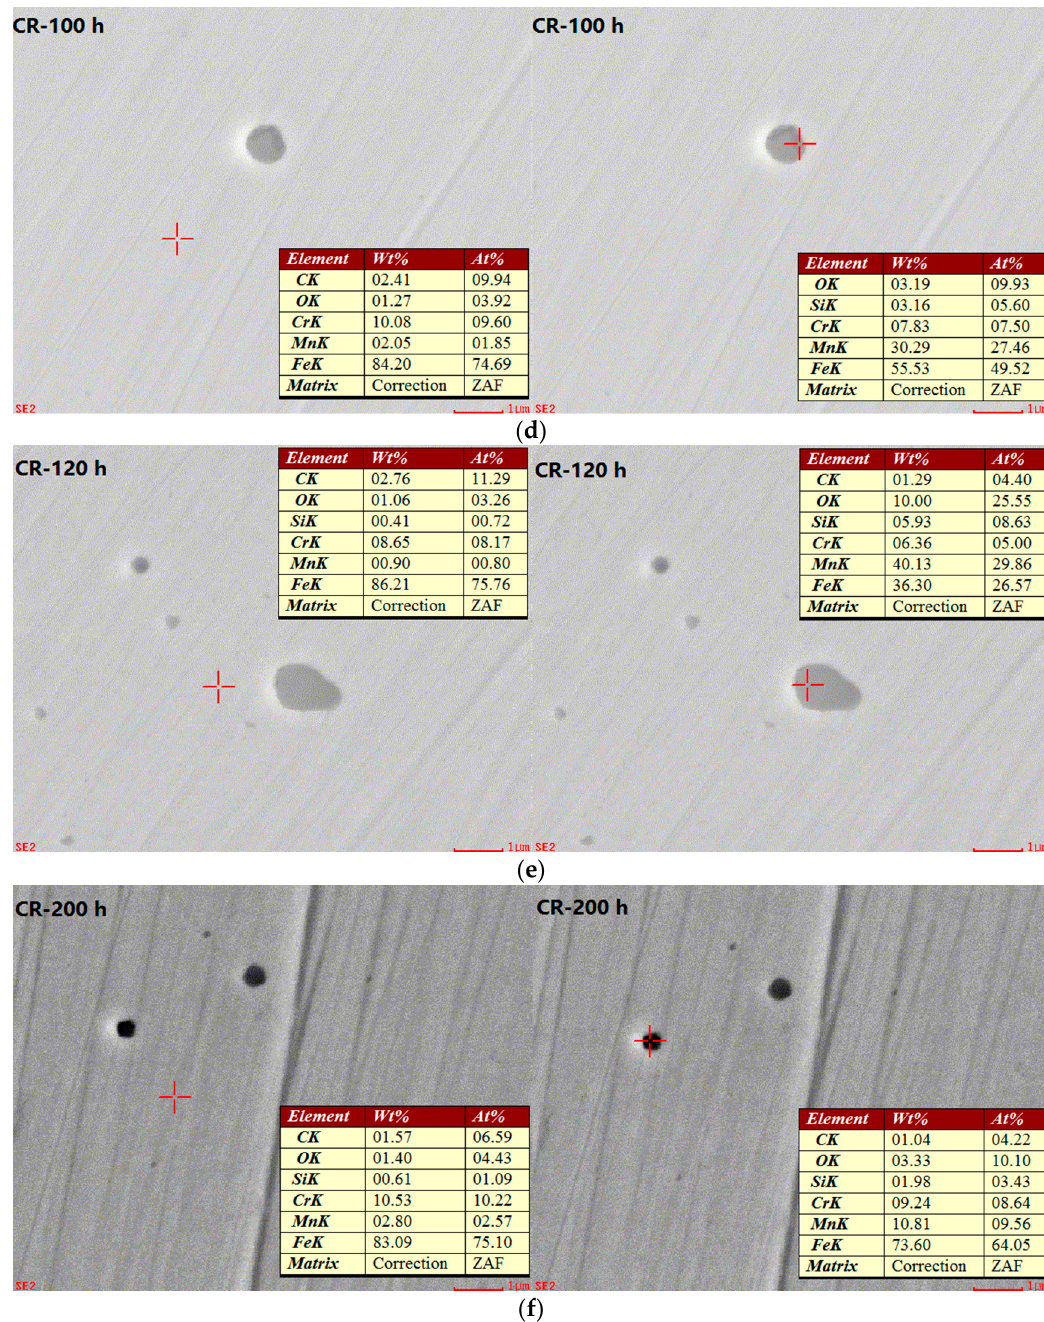
Figure 9. Energy dispersive spectroscopy (EDS) photos of corrosion-resistant alloy reinforcement bars at different corrosion exposure times. ( a ) EDS result of CR at 0 h; ( b ) EDS result of CR at 24 h; ( c ) EDS result of CR at 60 h; ( d ) EDS result of CR at 100 h; ( e ) EDS result of CR at 120 h; and ( f ) EDS result of CR at 200 h.